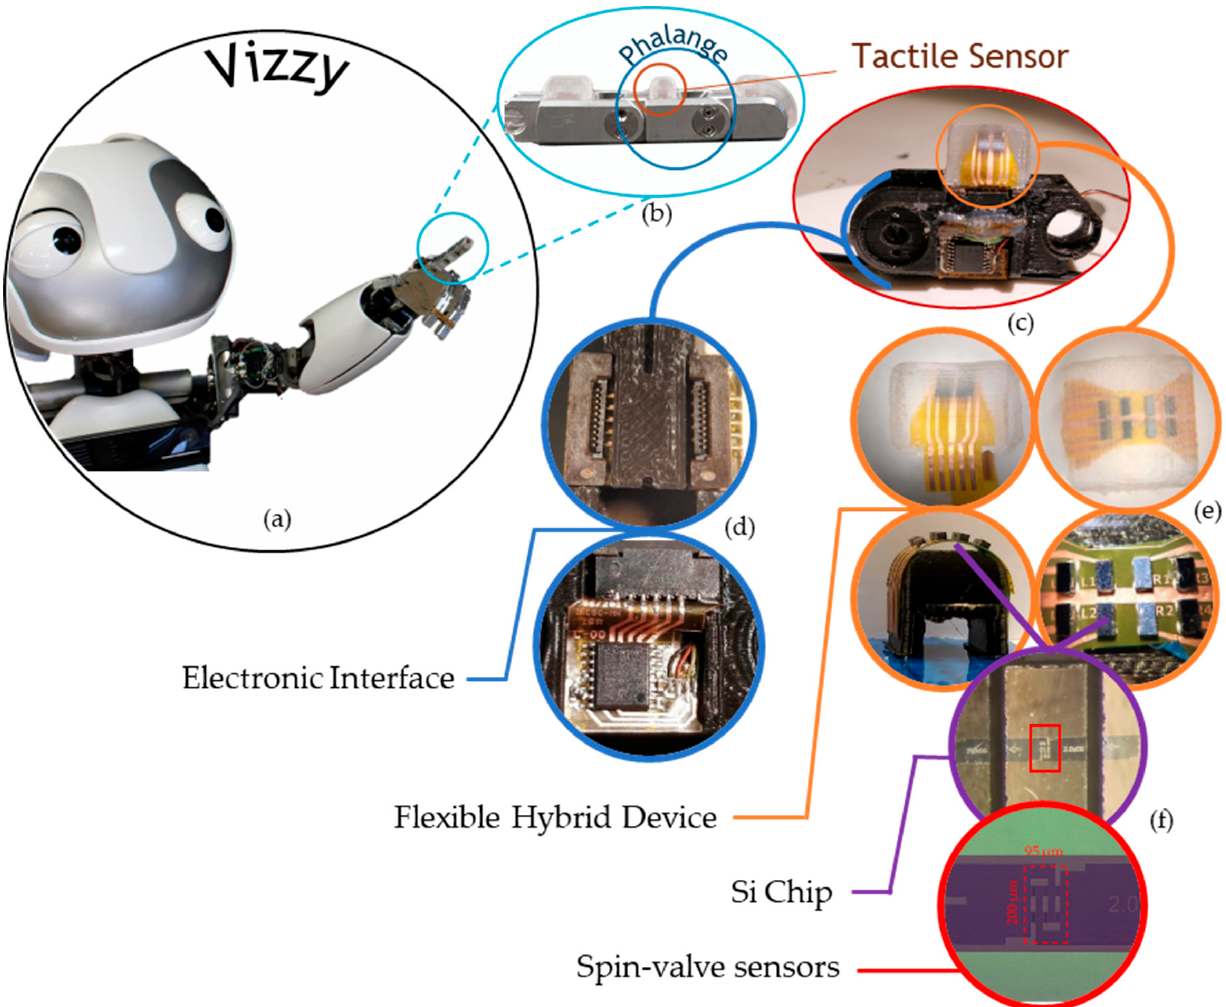
Figure 2. The robot, the finger, the sensor, the sensing elements, and their integration. ( a ) Vizzy; ( b ) a finger from Vizzy with three phalanges, each with a tactile sensor; ( c ) redesigned middle phalange part to integrate ( d ) the electronic interface and ( e ) flexible hybrid device with the flexible sensing matrix and the ( f ) Si chips with the spin-valve sensors.